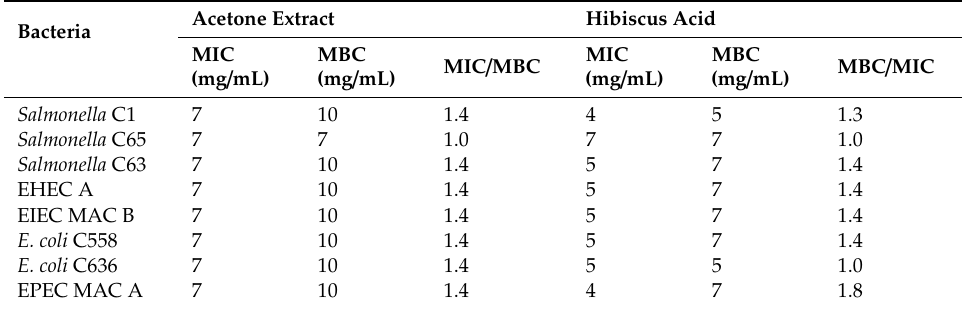
Salmonella C1 = S . Montevideo, Salmonella C65 = S . Typhimurium, Salmonella C63 = S . Typhimurium, EHEC A = enterohemorrhagic E . coli , EIEC MAC B = enteroinvasive E . coli , E . coli C558 and C636 = Shiga toxin-producing E